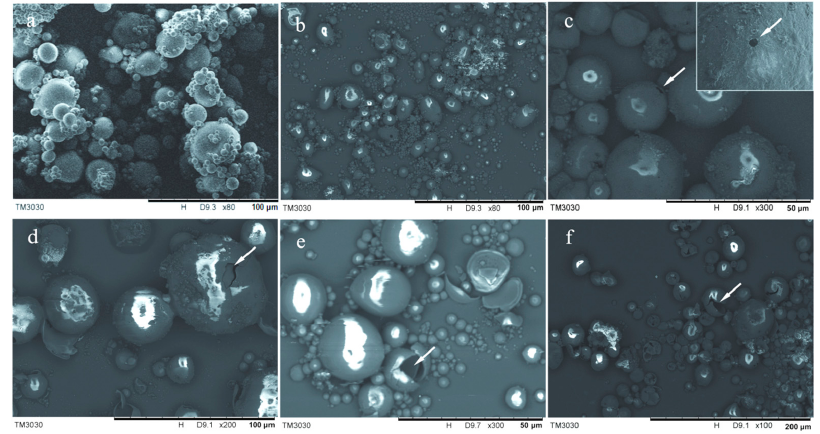
Figure 10. SEM morphologies of microPCMs sample (MG-2) at various temperatures, ( a ) 100 °C; ( b ) 150 °C; ( c ) 200 °C; ( d ) 250 °C; ( e ) 300 °C and ( f ) 350 °C.